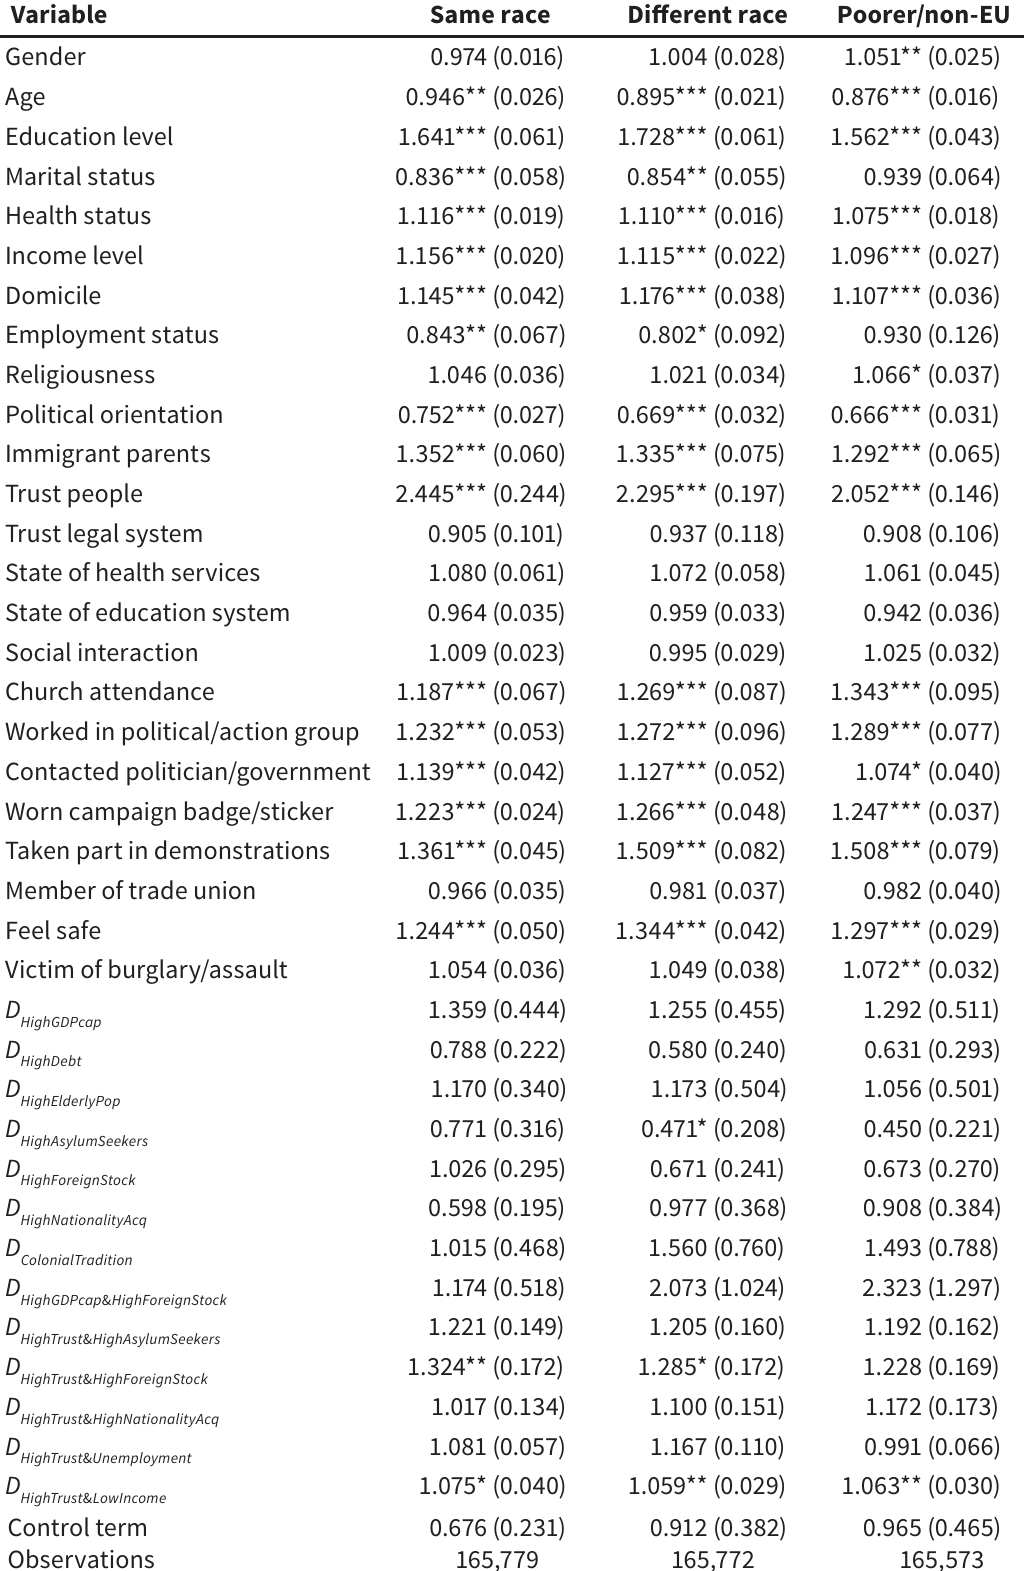
Estimates of Europeans’ attitude toward different immigrant types (odd ratios)